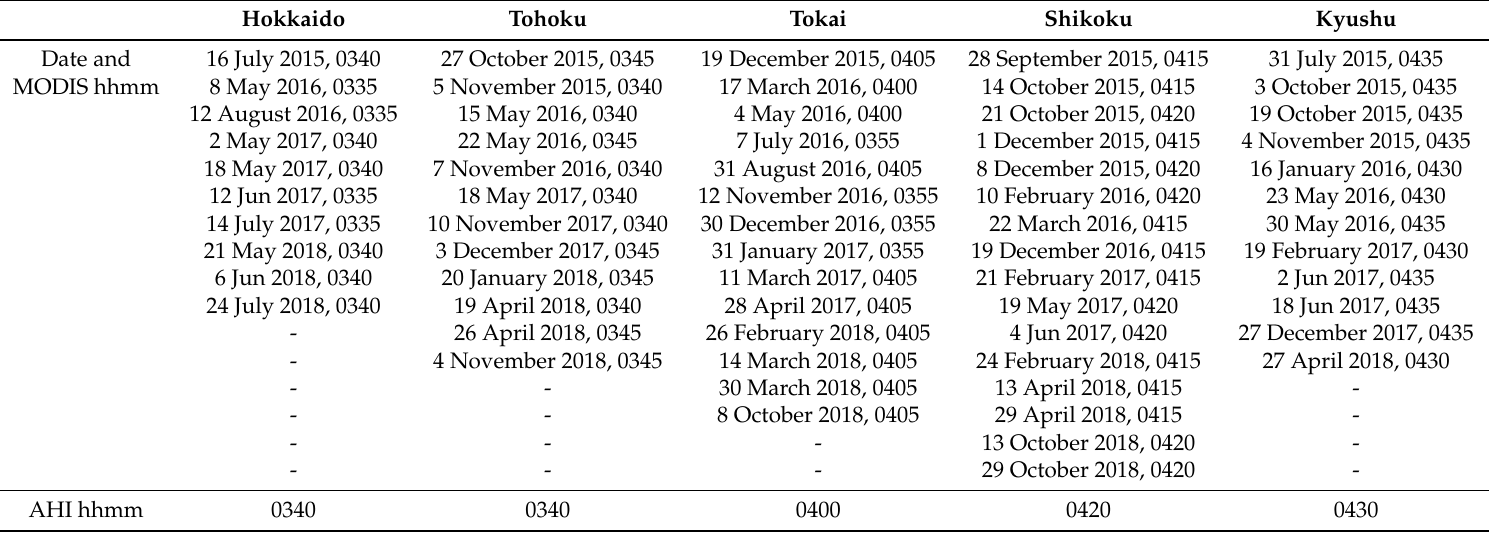
Table 2. Date and timestamp for MODIS and AHI data used in this study. The timestamp is represented by four digits for hour and minute “hhmm”.